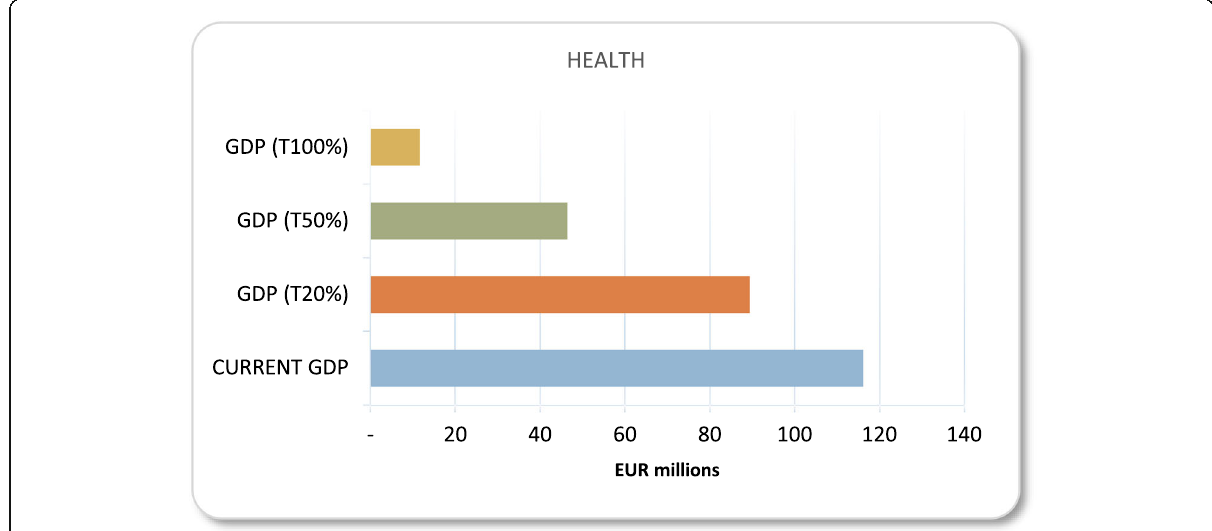
Fig. 17 GDP forecast of the Spanish health